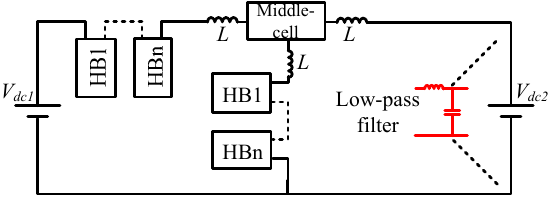
Figure 4. Single-phase DC-DC MMC in buck converter form.